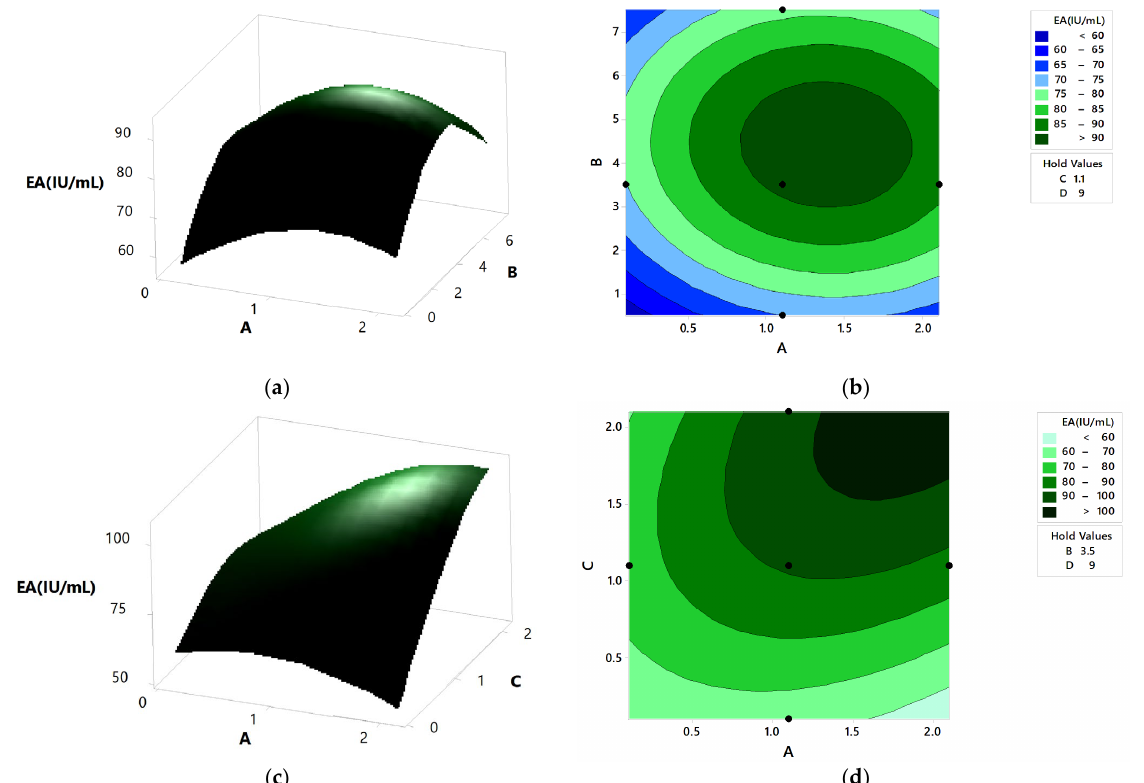
Figure 8. Pareto chart showing the standardized effects of four variables.